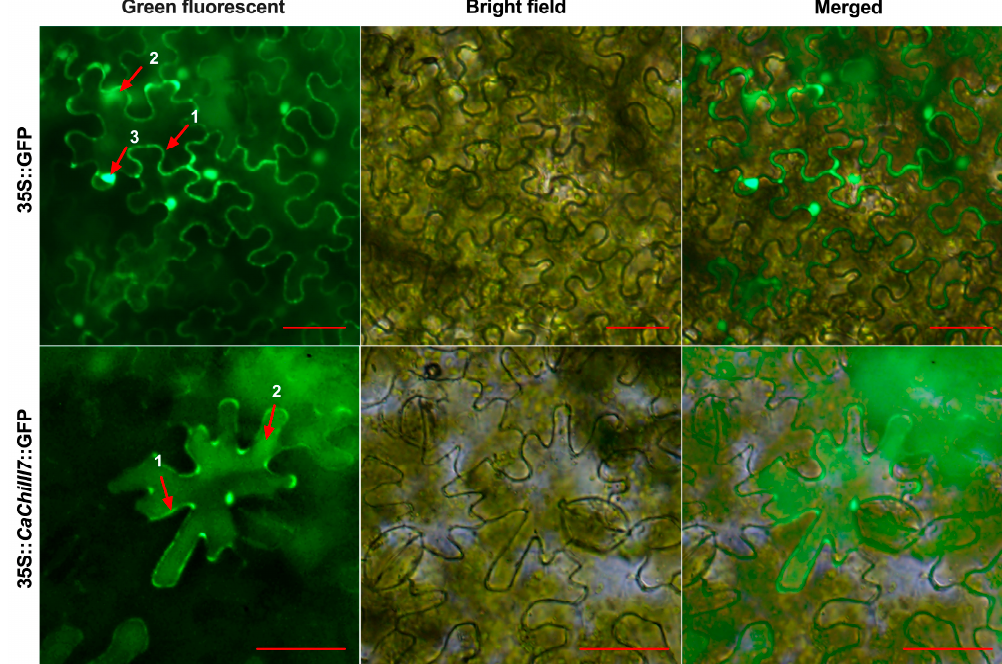
Figure 3. Protein localization assay of CaChiIII7. Transcript of CaChiIII7 fused with green fluorescence protein (GFP) via Agrobacterium -mediated transient expression in Nicotiana benthamiana epidermal cells. The GFP signals were visualized using a fluorescent confocal microscope (Olympus BX63) with an emission 509 nm and 488 nm excitation wavelengths (Olympus, Tokyo, Japan) after 48 h of agroinfiltration. The numbers 1, 2, and 3 represent the cell membrane, cytoplasm, and nucleus, respectively, and the red line at the bottom right corner of each picture equals 50 μ m.